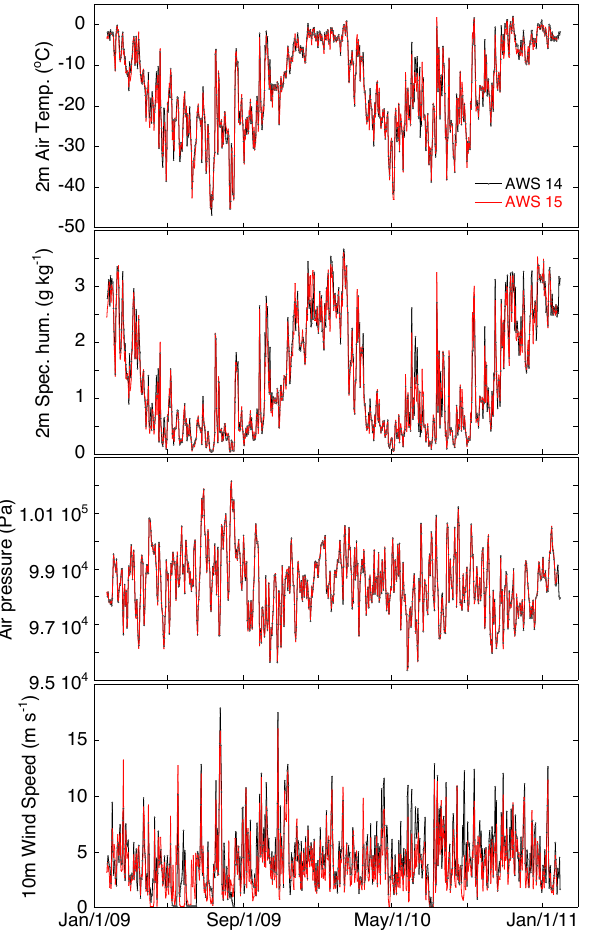
Fig. 2. Daily-averaged air temperature, specific humidity, air pres- sure, and wind speed for the measurement period. AWS 14 data are shown in black with circles, AWS 15 is shown in red.